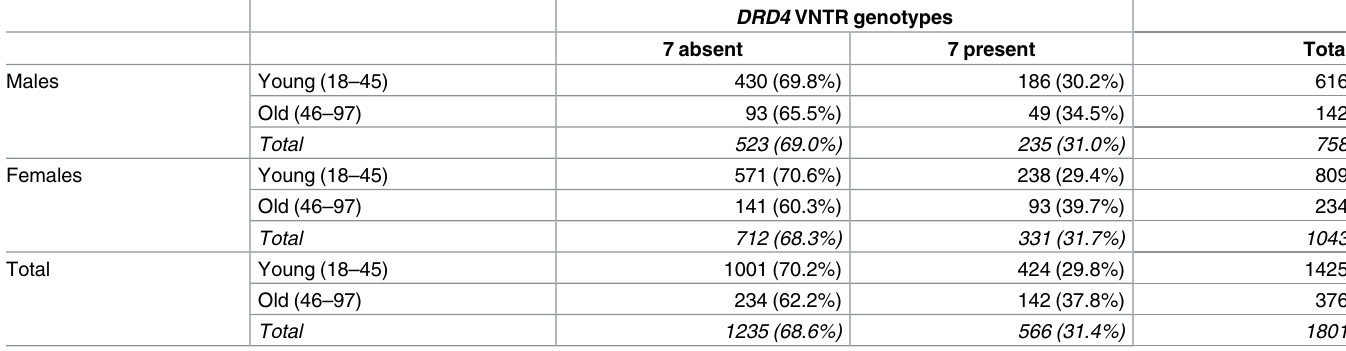
Table 2. DRD4 allele 7 frequency changes with age and gender.